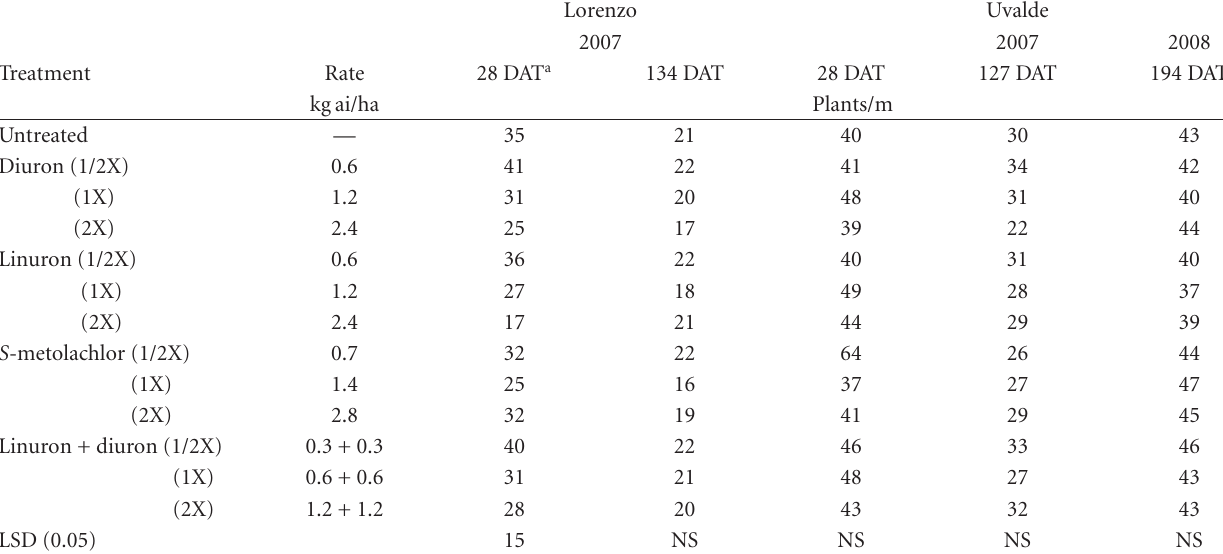
Table 1: Sesame stand response to preemergence herbicides at two locations in Texas.